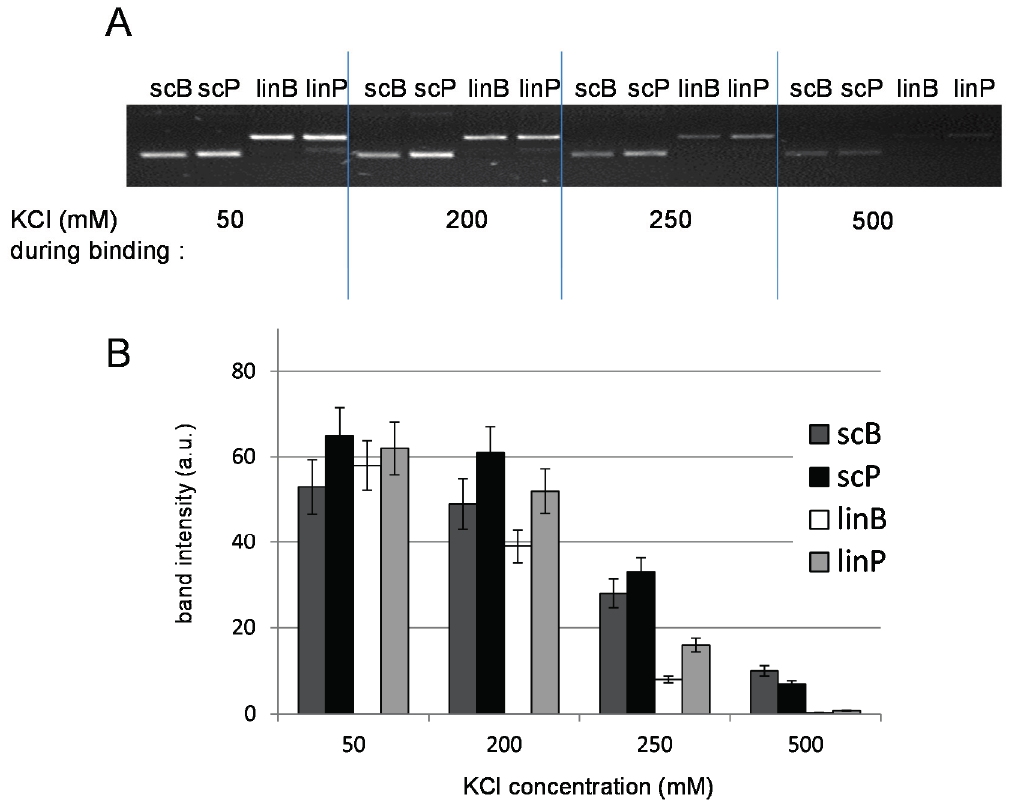
Figure 2. Effects of KCl concentration on the formation of the p53-DNA complexes. ( A ) Agarose gel electrophoresis of recovered DNA after the MBIP assay (Figure 1); and ( B ) Histograms showing relative intensities of bands of the recovered sc and lin forms of pBSK and pPGM1 plasmids (see legend in the figure). (DO-1)-p53-DNA complexes